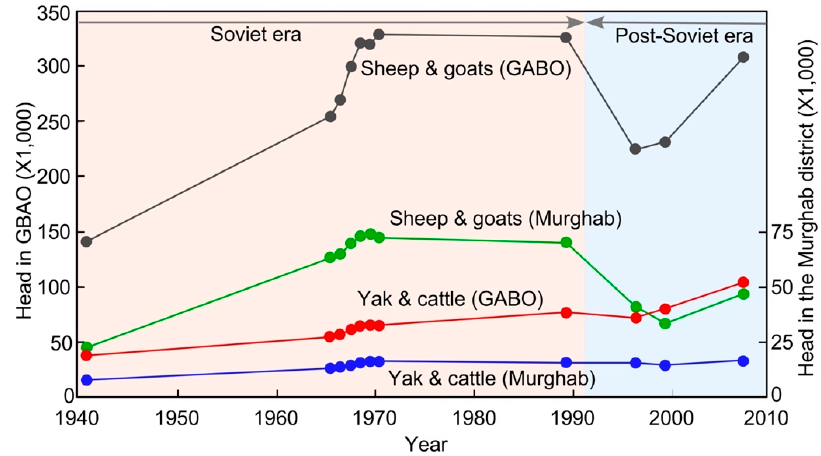
Figure 2. The changes in livestock number in GBAO and the Murghab district from 1941 to 2008 (Data source: GBAO Statistic Committee and Stat Passport of Rayons, 2009 and Ob1Stat GABO).